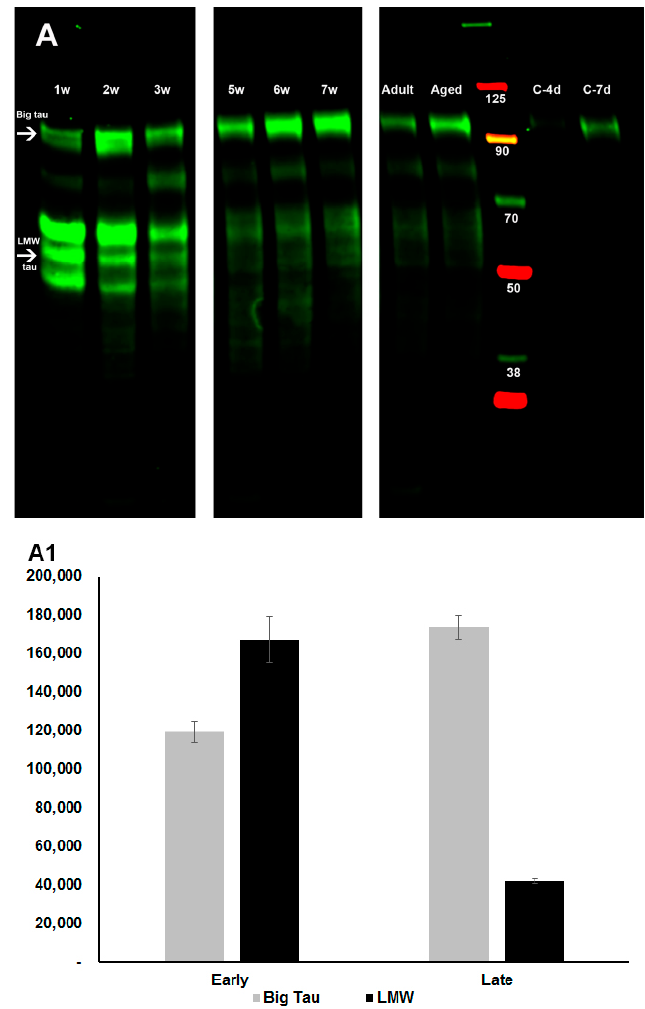
Figure 2. Exon structure of Big tau in SCG and DRG. ( A ) shows PCR analysis of DRG (1) and SCG (2) indicating the presence of exons 2 and 3 at the N ‐ terminal ( A.1 ), exons 4A and 6 ( A.2 ); and exon 10 indicating a 4R structure ( A.3 ). The sequence of the primers shown on the right side of the PCR images. ( B ) shows a graphical representation of Big tau exons and the PCR products.